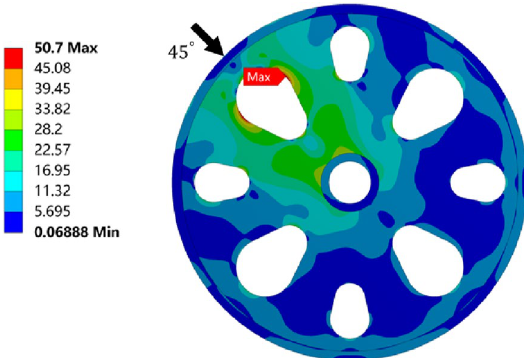
Figure 22 Stress distribution and the location of maximum stress under a maximum radial force at 45